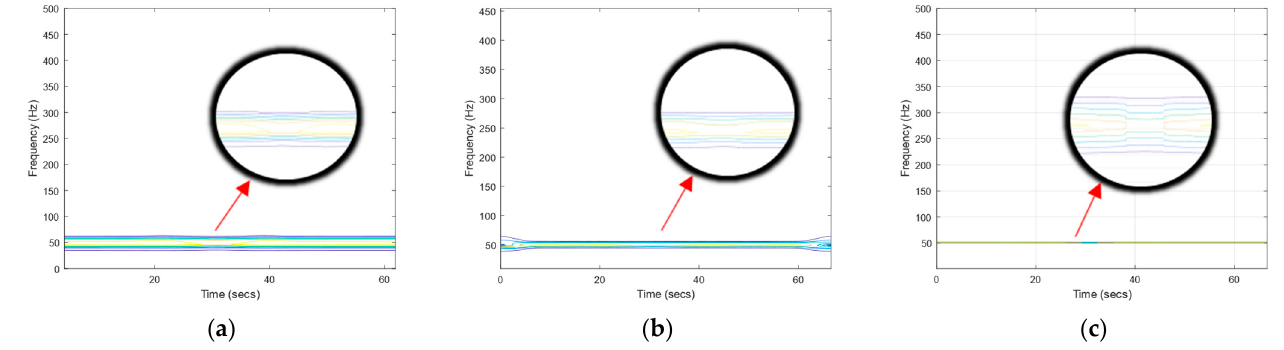
Figure 4. Comparison of contour lines of STFT, CWT, and SSWT. ( a – c ) are time frequency contour plots of STFT, CWT and SSWT respectively